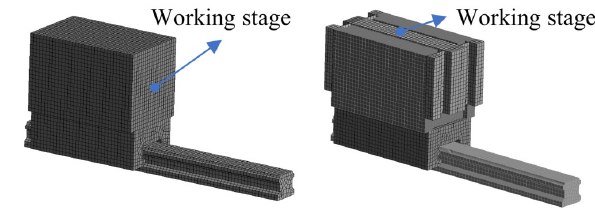
Figure 6. FEM of two types of motion stages: RMS ( left ) and RFCMS ( right ).